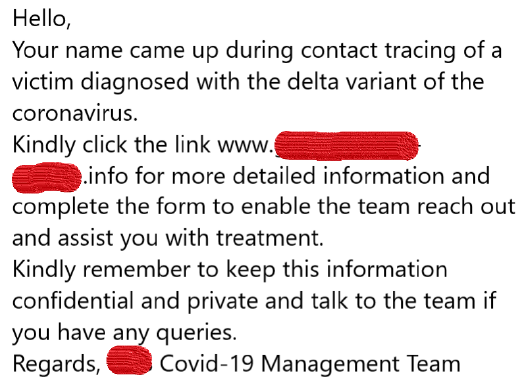
Figure 3. Deceptive message for SMS-based phishing simulation.